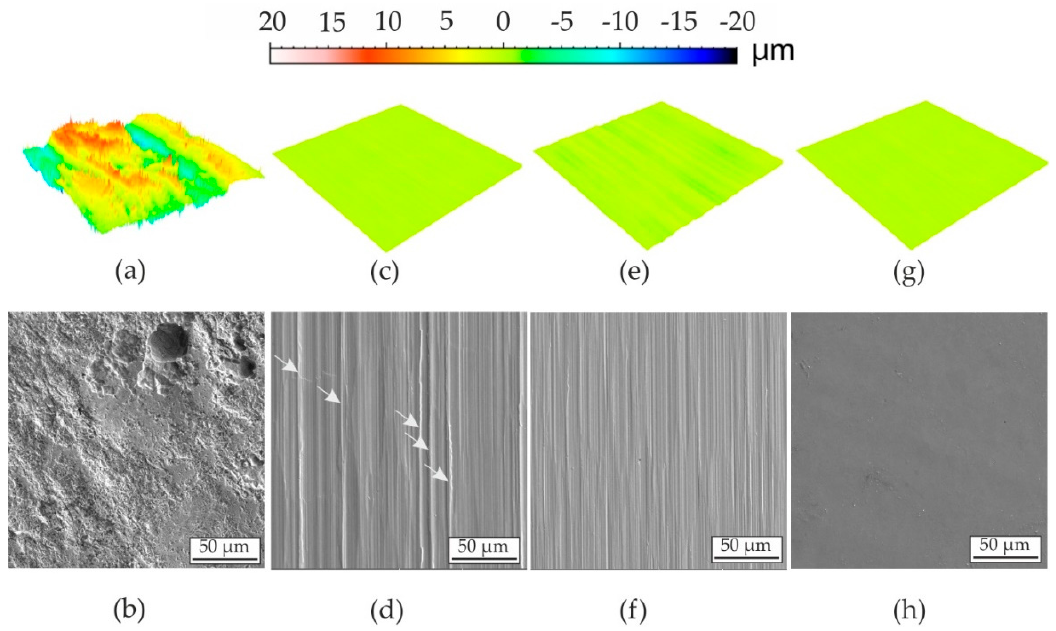
Table 4. Mean roughness ( R z ) in µm of the investigated surface morphologies.